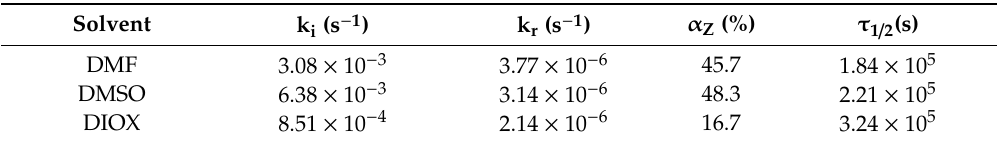
Table 5. AZO2 E-Z photoisomerization rate constants at 303K. In this order: k i , direct isomerization kinetic constant; k r , thermal relaxation kinetic constant; α Z , content of the Z -isomer at the PSS (photo-stationary state); τ 1 / 2 , half-life of Z -isomer in the dark.